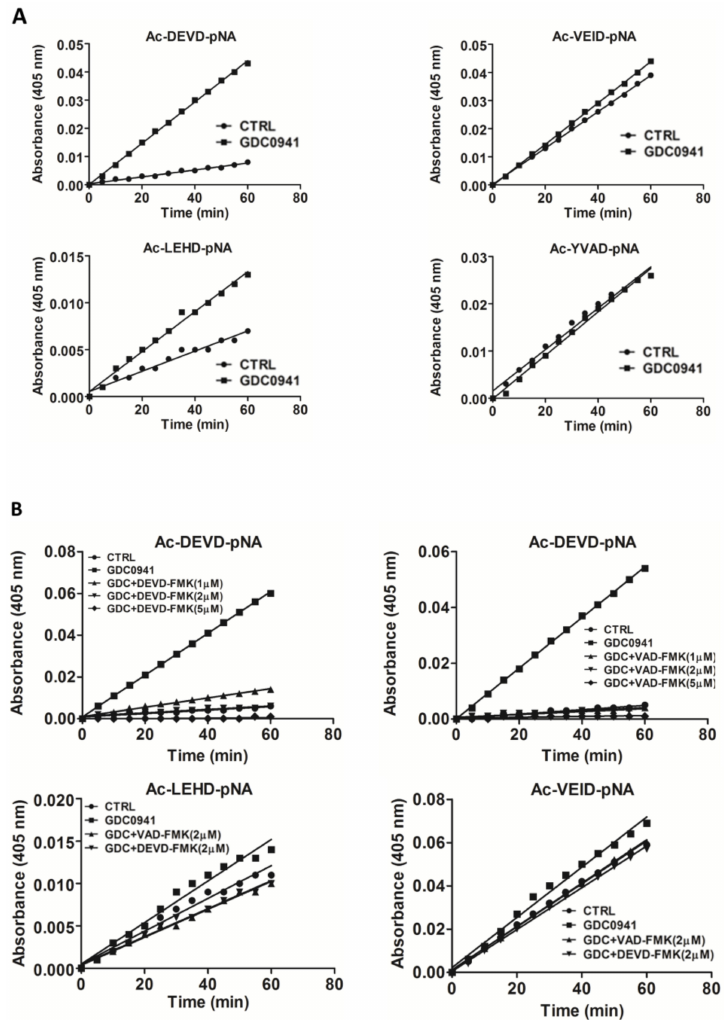
Figure 3. Effect of selected protease inhibitors on the activity of individual caspases during GDC-0941 treatment. ( A ) Proteolytic activities in cell lysates toward individual substrates were determined 2 h after GDC-0941 treatment. ( B ) Effect of pre-treatment of cells with selected concentrations of the Z-DEVD-FMK and Z-VAD-FMK protease inhibitors on the proteolytic activity in cell lysates. Activity was determined 2 h after GDC-0941